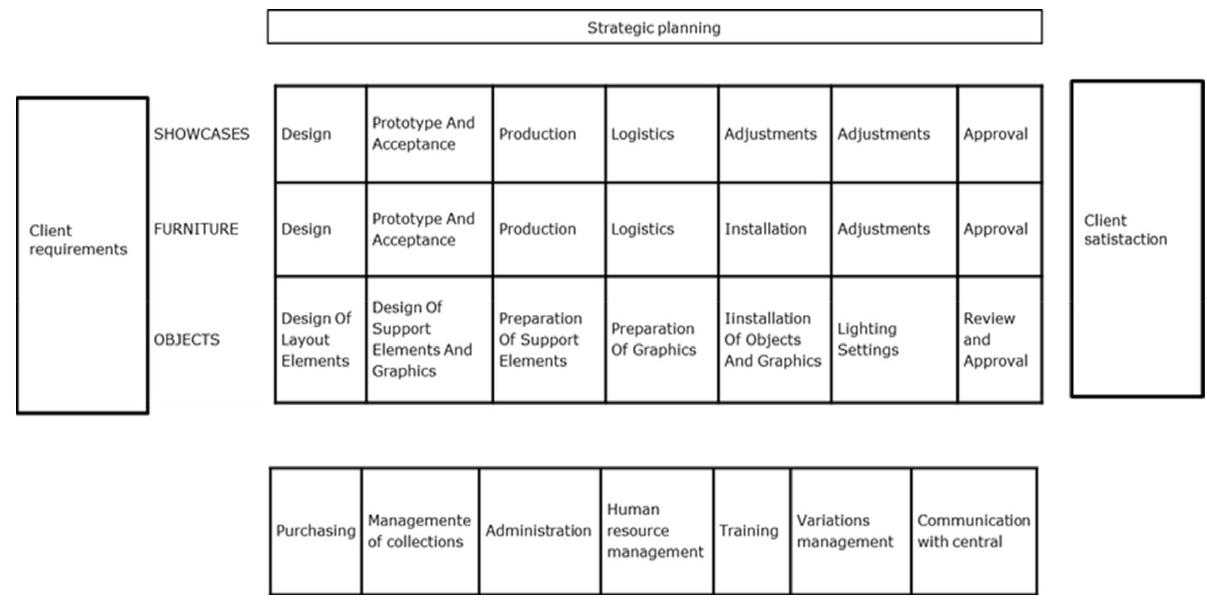
Figure 2. AS-IS Process Mapping